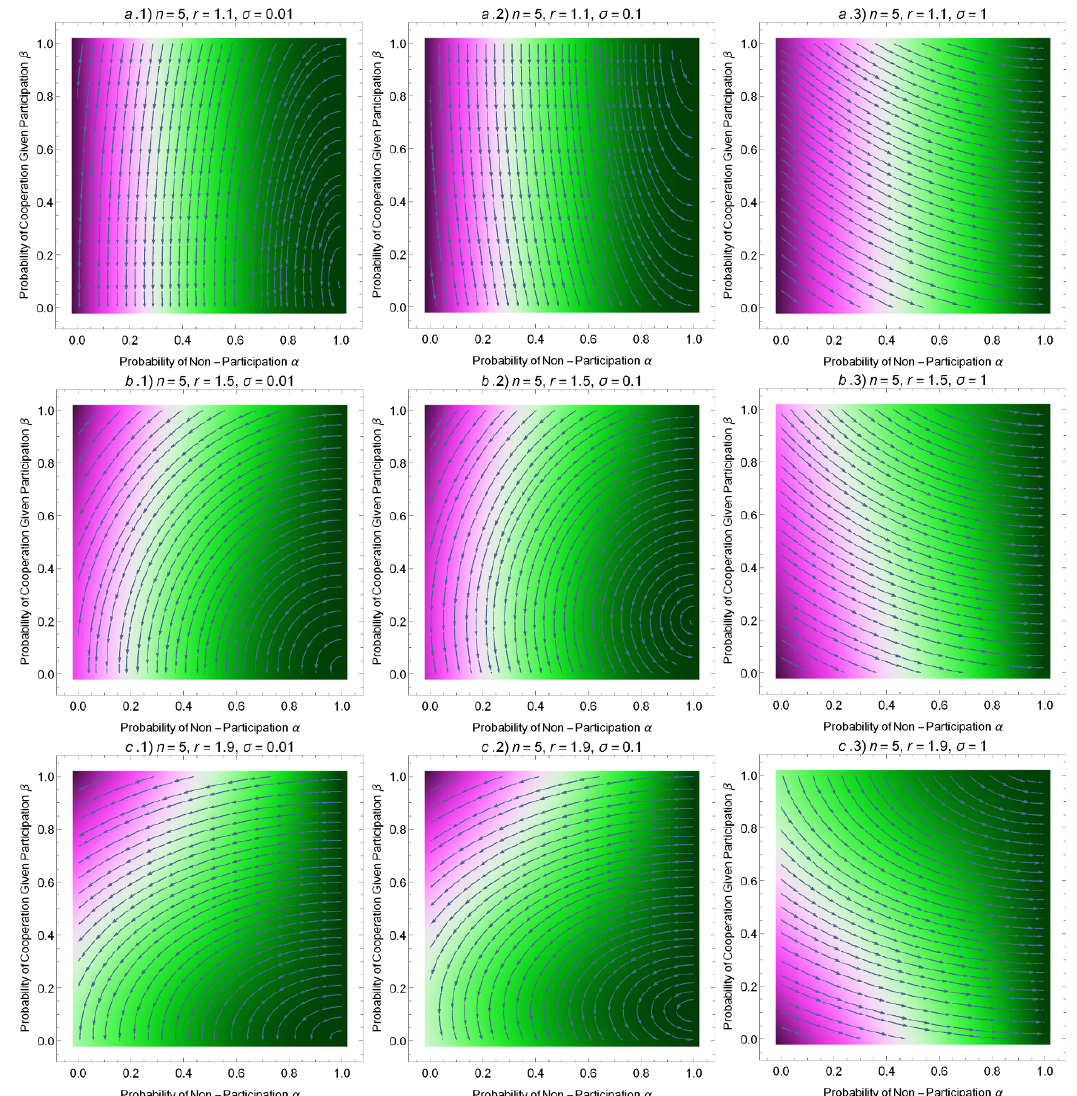
Figure 4. Coevolution of cooperation and stochastic opting-out. Shown in Panels ( a – c ) are the adaptive dynamics using the StreamPlot function of Mathematica in a finite population of size n = 5 for the selection pressure γ = 1 and various values of return on investment, r , and payoff for non-participants, σ . Following the arrows leads to the most likely path the population will take in the strategy